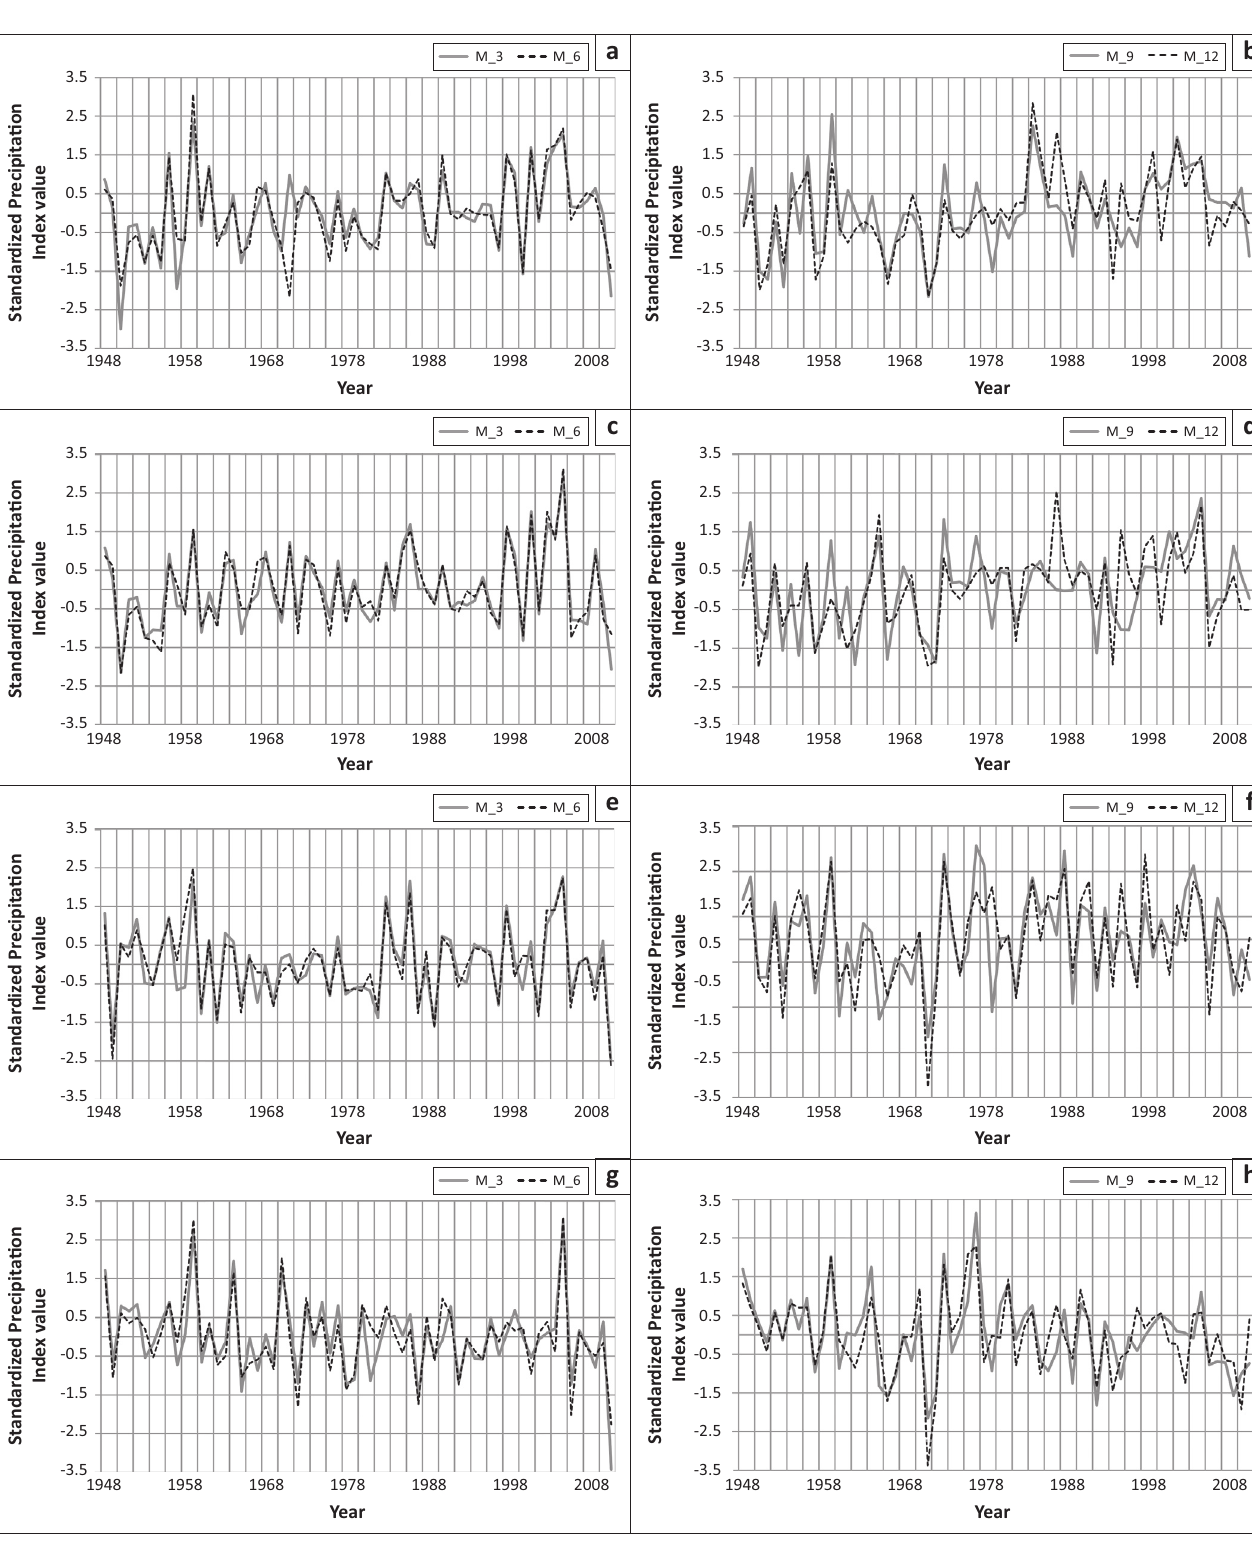
Figure 2 continues on the next page